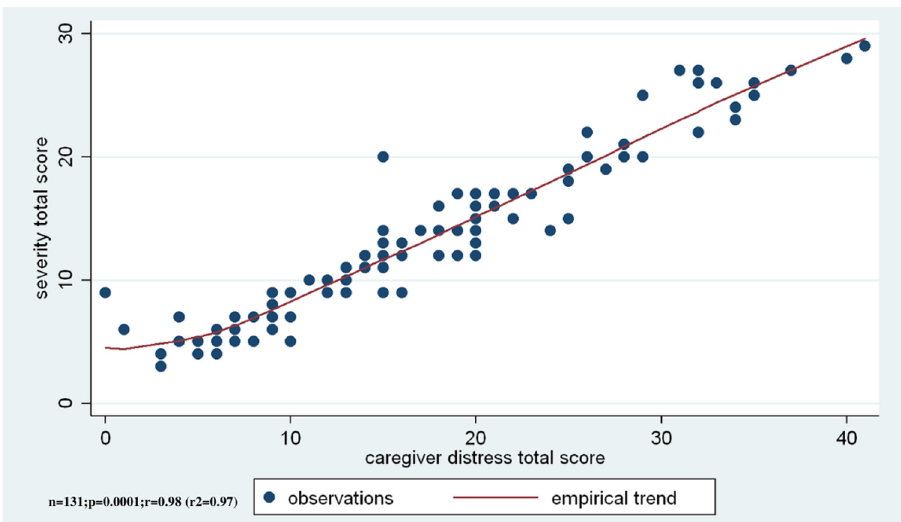
Figure 5: The caregiver ’ s distress level shows a signi fi cant positive correlation to the total score of “ NPSs severity. ”